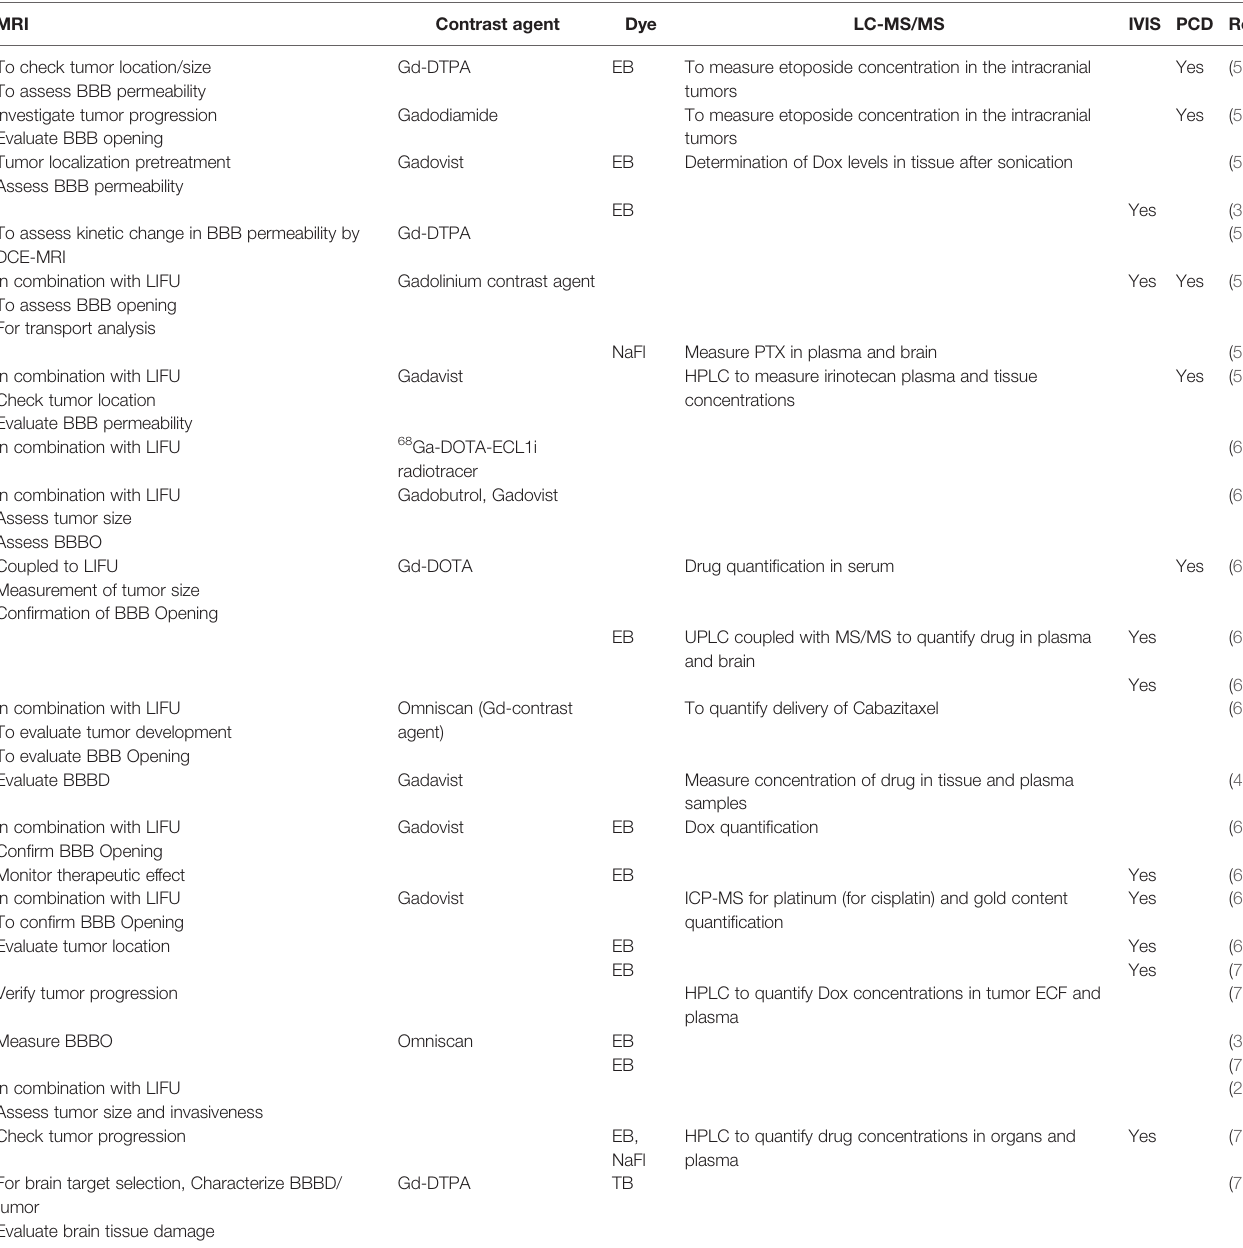
TABLE 5 | The purpose of using imaging, quanti fi cation of therapeutics, and monitoring of MB activity in preclinical studies. MRI Contrast